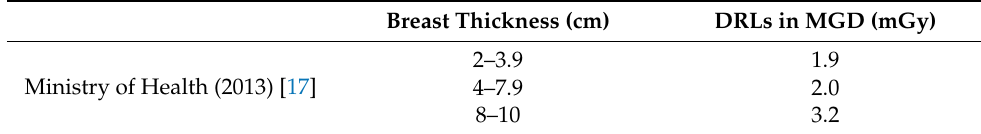
Table 8. Diagnostic Reference Level for mammography in Malaysia